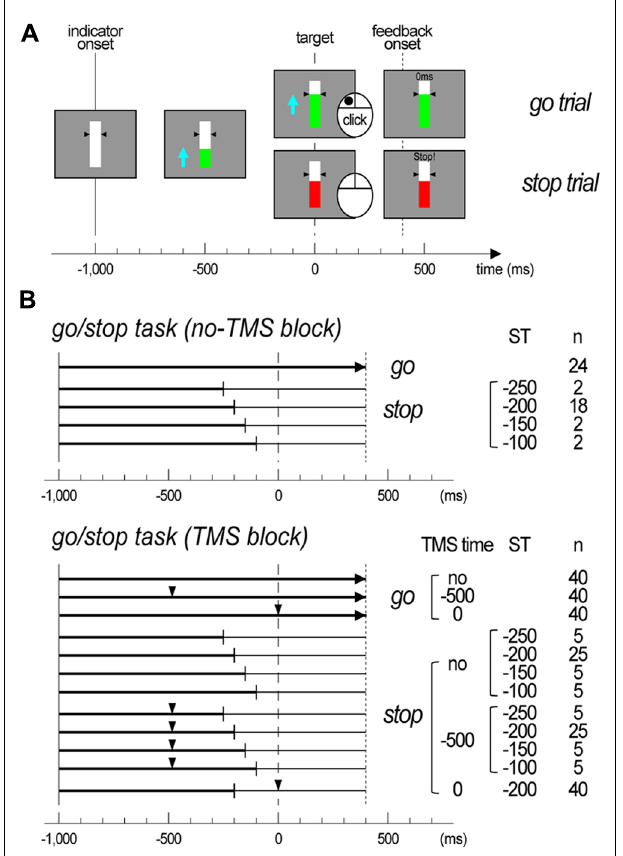
FIGURE 1 |Task designs of experiments. (A) Illustrations of the display for the go/stop task.The trial type is noted on the right side, and the time scale is displayed at the bottom. (B) Illustrations of trial structure for the go/stop task with and without transcranial magnetic stimulation (TMS).The time scale is displayed at the bottom.The vertical lines at − 1,000 ms represent the indicator onset, the vertical dashed lines at 0 ms represent the target, and the vertical dotted lines represent the feedback onset.The small triangles represent the time points at whichTMS was delivered (TMS time).The trial type is noted on the right side, with theTMS time, stop time (ST), and total number of trials. In the stop trials, the time points at which an indicator stopped are shown with vertical thin